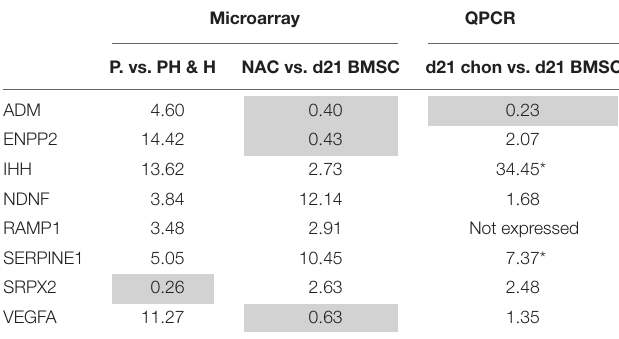
TABLE 1 | Selection of IHH and SERPINE1 via microarray and PCR